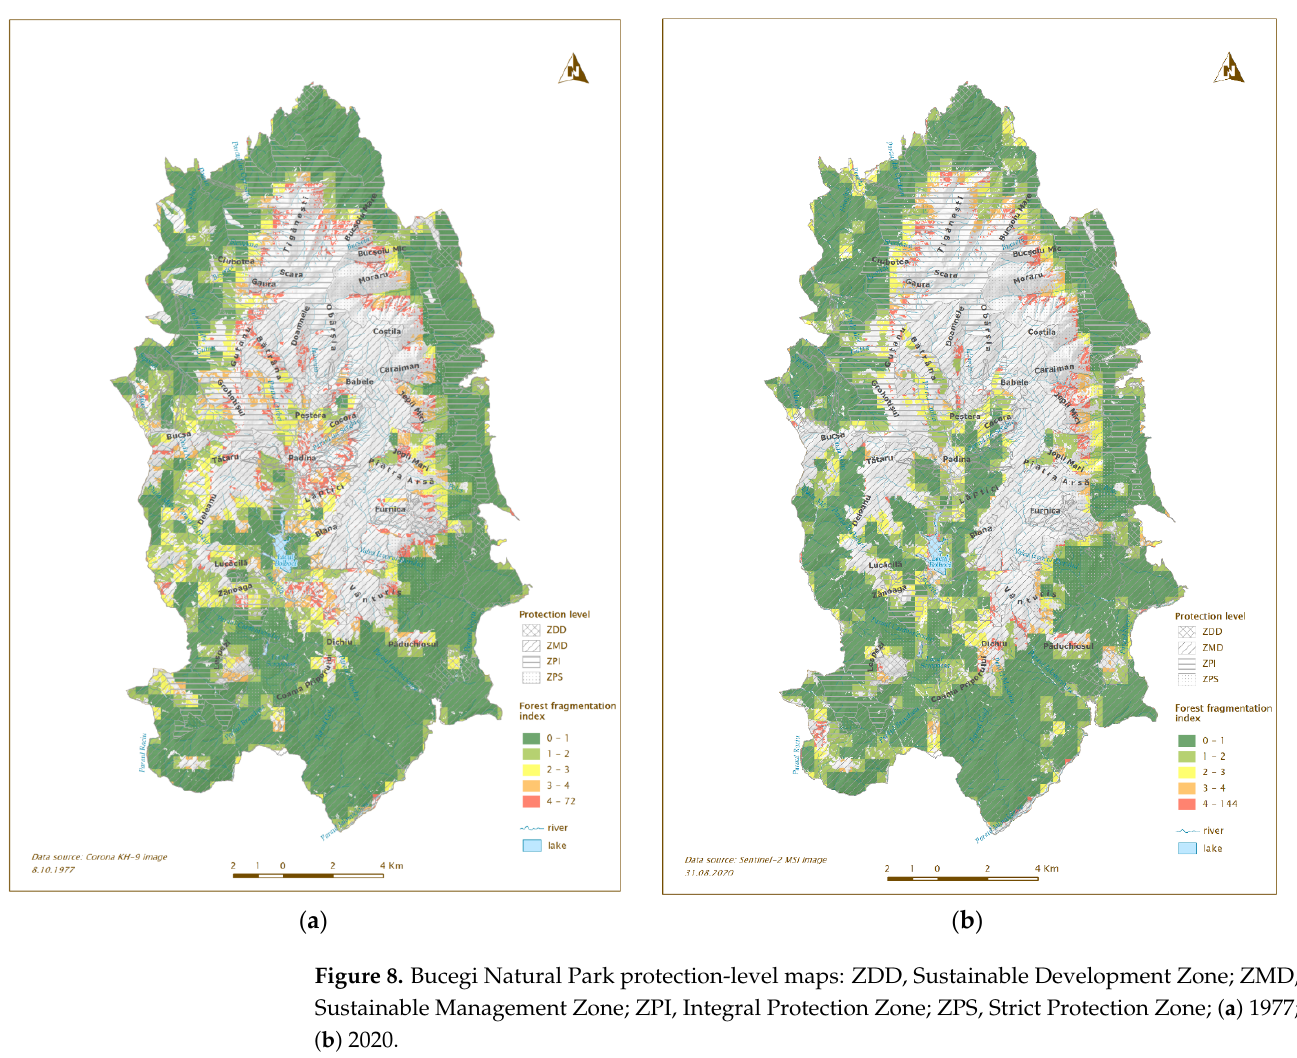
Figure 8. Bucegi Natural Park protection-level maps: ZDD, Sustainable Development Zone; ZMD, Sustainable Management Zone; ZPI, Integral Protection Zone; ZPS, Strict Protection Zone; ( a ) 1977; ( b ) 2020.